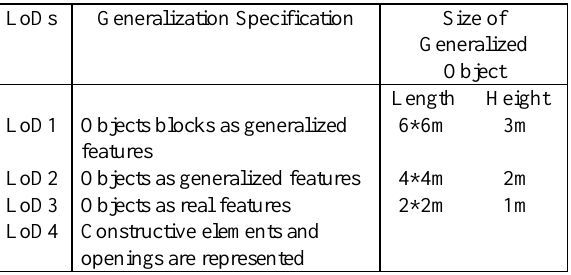
Figure 2. Workflow of a unified generalization